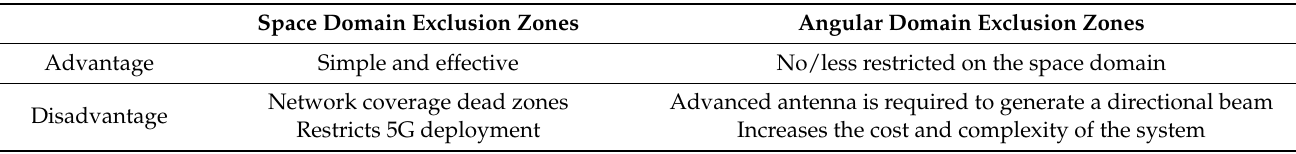
Table 1. Advantages and disadvantages of using various protection